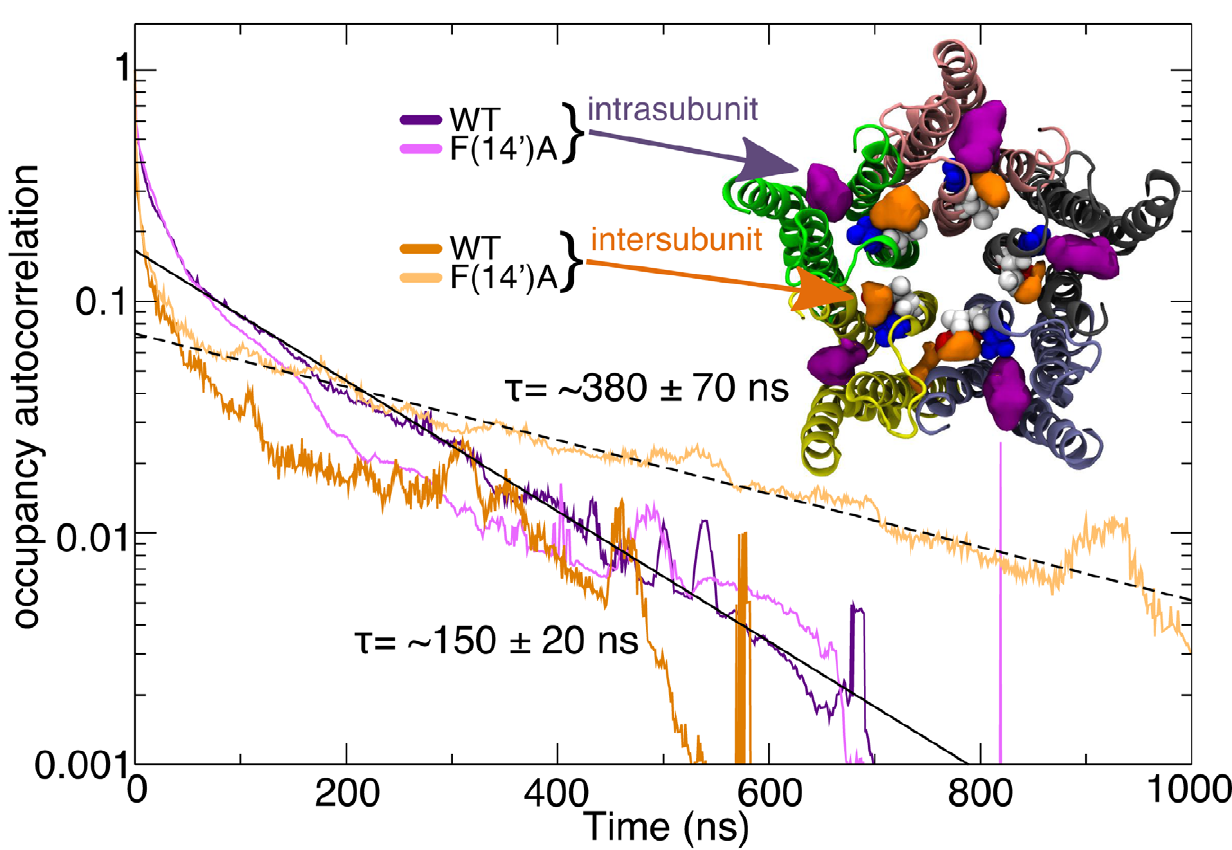
Figure 6. Ethanol exchange rates. Occupancy autocorrelations for ethanol molecules that exhibit cavity occupancy at some point in each simulation, colored according to the site and system. The slow component of ethanol exchange was fit by an exponential (solid line) with t , 150 ns and a standard error of 20 ns for the intra-subunit WT (dark purple). The F(14 9 )A (light purple) site is not does not exhibit any statistically significant difference, and the very limited amount of ethanols present inter-subunit for WT (dark orange) makes a fit difficult. In contrast, the inter-subunit F(14 9 )A cavity (light orange) exhibits significantly slower exchange, fit by an exponential (dashed) with t , 380 ns and a standard error of 70 ns.